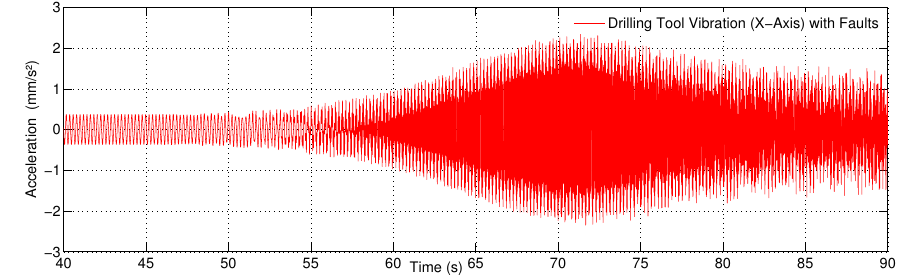
Figure 8. Drilling Tool vibration along the x-direction with the induced